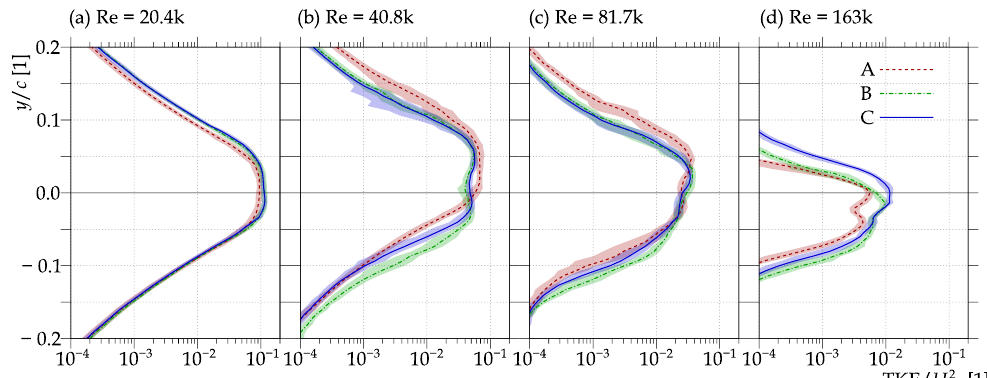
Figure 15. The cross-stream profile of the turbulent kinetic energy (TKE) at stream-wise distance 10mm = 1/8 c past the trailing edge. Angle of attack α = 0 ◦ in all panels. Note the logarithmic scale. The spatial distribution of length-scale dependent TKE is shown in Figure 14. At